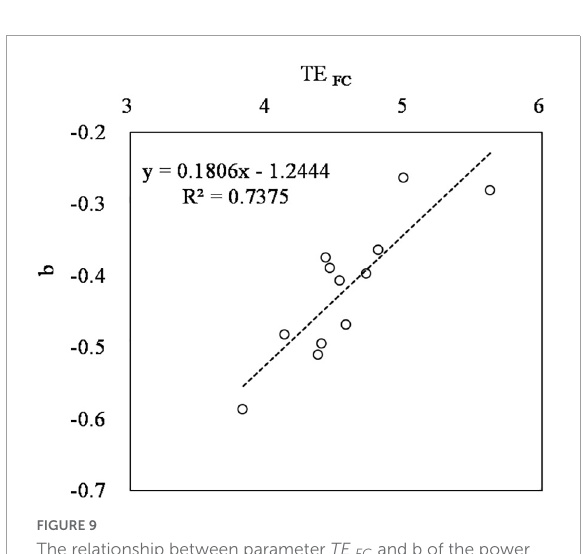
FIGURE9 The relationship between parameter TE FC and b of the power function TE = TE FC × ( RSWC ) b in TE shoot (transpiration efficiency of shoot, the ratio of shoot mass to transpiration